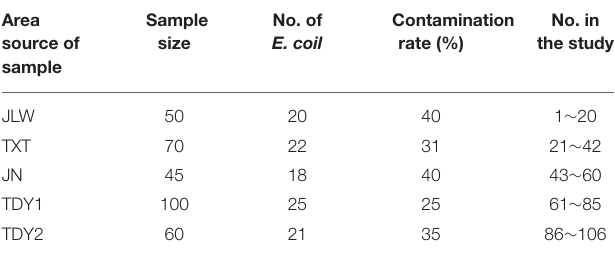
TABLE 1 | The results of isolation and identification of swine origin Escherichia coli strains. Area source